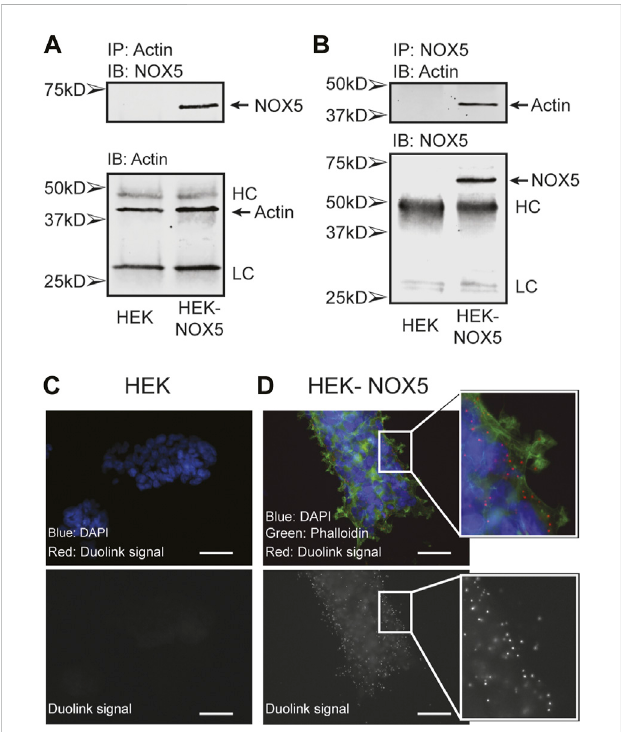
FIGURE 1 Actin and NOX5 interact in the cell. Co-immunoprecipitation of ActinandNOX5.EqualamountsoflysatefromHEK293andHEK293cells stably expressing NOX5 were (A) incubated with anti- β -actin antibody and pulled down with Protein G Sepharose beads or (B) incubated with anti-NOX5 antibody and pulled down with Protein A Sepharose beads. After washing the precipitates were subjected to SDS-page and western blot analysis for β -actin and NOX5 (full blots in Supplementary Material,HC,heavychain;LC,lightchain). (C,D) Theinteractionbetween β -actin and NOX5 in HEK293 cells and HEK293 cells stably expressing NOX5 was probed using the Proximity Ligation Assay (PLA) Duolink kit from Sigma. Red foci represent interaction between the two proteins ( < 40 nm). (C) Control slide of HEK293 cells with both primary antibodies (anti-NOX5 and anti- β -actin) and both probes. Top panel shows overlap of DAPI (blue) and Duolink signal (red). Bottom panel shows red channel signal in greyscale. In the absence of NOX5 expression, the assay does not result in red foci. (D) Addition of both antibodies and probes to the HEK293 cells stably expressing NOX5 results in bright red foci indicating an interaction. Top panel shows overlap of DAPI (blue), phalloidin for fi lamentous actin (green) and Duolink signal (red). Bottom panel shows red channel signal in greyscale. Scale bars are 50